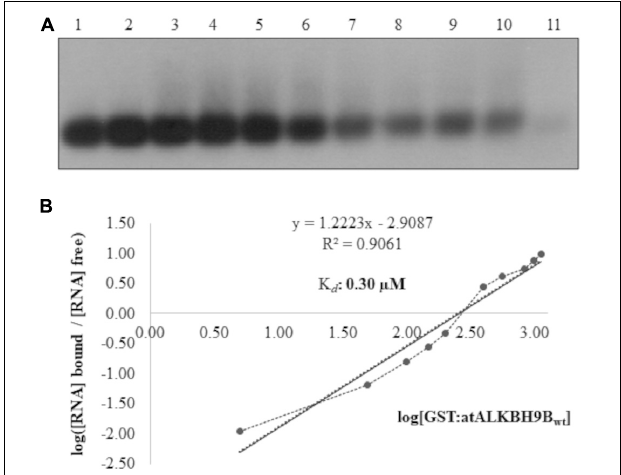
FIGURE 1 | Analysis of RNA-protein complexes formed between purified GST: at ALKBH9B wt protein and the 3 (cid:48) UTR transcript of AMV-RNA3/4. (A) EMSA after incubation of 5 ng of 3 (cid:48) UTR transcript with no protein (lane 1) or with 5, 50, 100, 150, 200, 400, 560, 840, 980, and 1120 ng of GST: at ALKBH9B wt (lanes 2–11) corresponding to 0.01, 0.06, 0.12, 0.18, 0.24, 0.48, 0.67, 1.00, 1.17, and 1.22 µ M, respectively. (B) Hill transformation. The thin line is the best fit determined by least-squares analysis, with the corresponding r coefficient and equation given in the insert. The slope of the best-fit equation determines a Hill coefficient of 1.35, indicating no or mild cooperativity, and the y -intercepted point gives the value of the K d , which was 0.30 µ